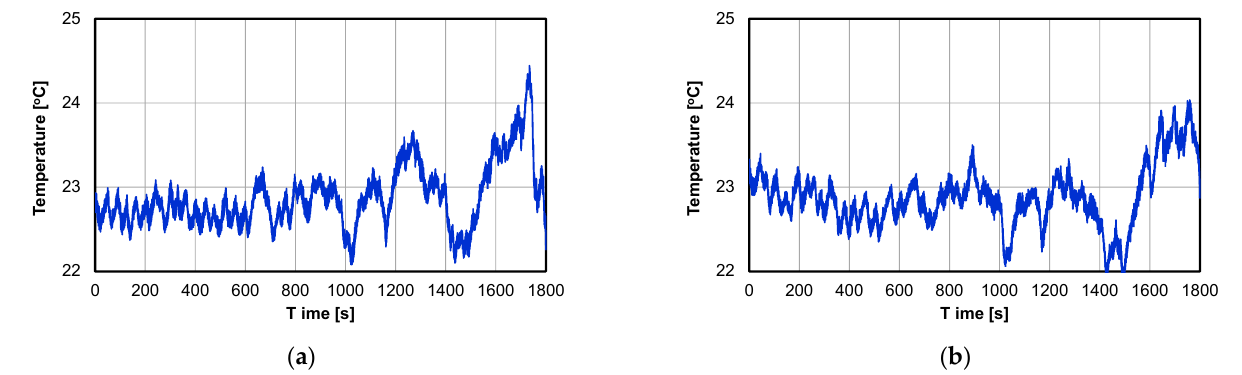
Figure 4. Temperature of dry air versus time for: ( a ) plug-in; ( b ) HEV.